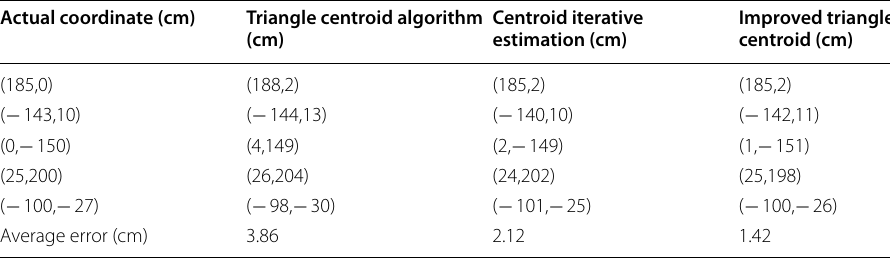
Table 3 Experimental result in test scenario Actual coordinate